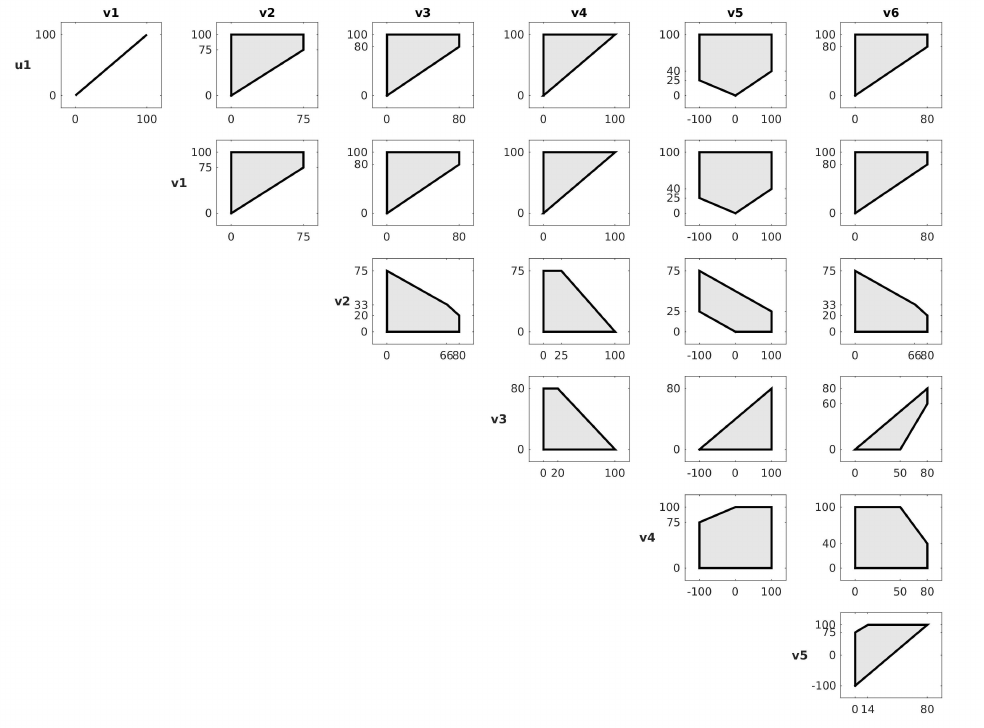
Figure 4. Pairwise projection of the solution space C defined by Equation (11). Only the 6 first reactions are presented. The full picture is in Supplement Figure S1. On each plane, the black lines are the limits of the projection of the solution space while the grey area represents its interior. To obtain these figures, we project the Elementary Flux Vectors (EFV) on each plane. Each projection of EFV is seen as a point on the plane. As all EFV in our model are bounded, we determine the projection of the solution space by finding the bigger polygon (in the sense of inclusion) we can make from each